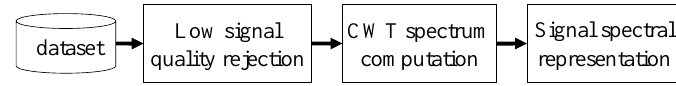
Figure 2. Proposed signal processing